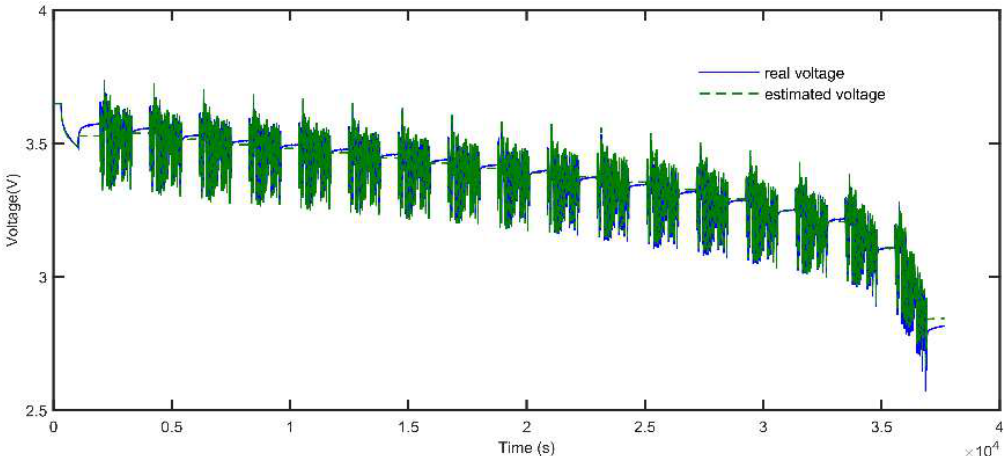
Figure 8. Comparison of real and estimated voltage of test 1 under dynamic condition.